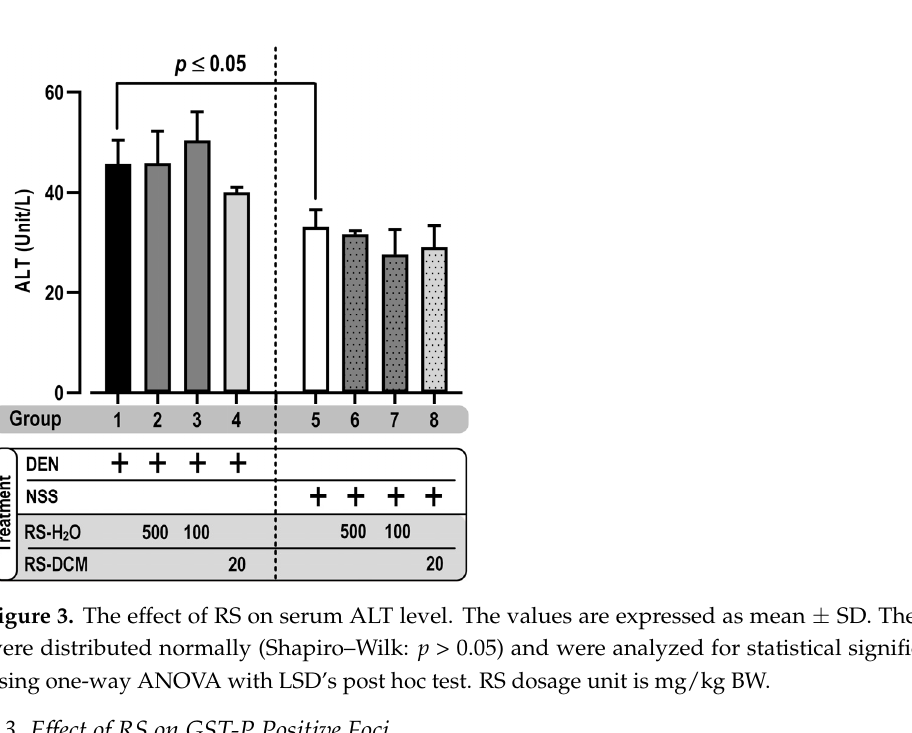
Figure 2. The e ff ect of CP on relative vital organ weight. The values are expressed as mean ± SD. The data were distributed normally (Shapiro–Wilk: p > 0.05) and were analyzed for statistical signi fi cance using one-way ANOVA with LSD’s post hoc test. RS dosage unit is mg/kg BW.